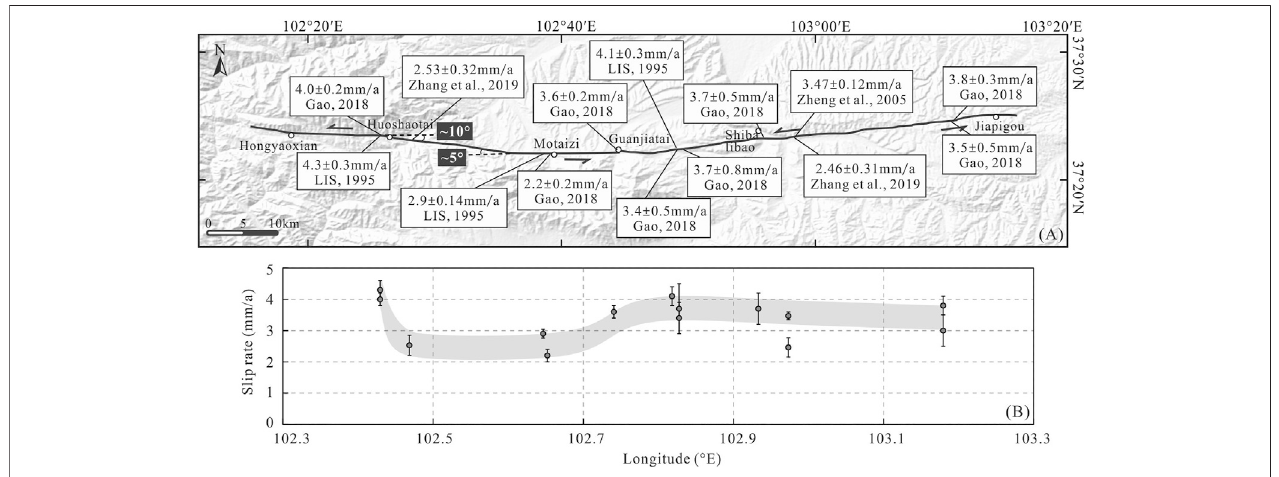
FIGURE 6 | (A) Distribution of left-lateral strike-slip rates along the Gulang fault. The slip rates are from (Lanzhou Institute of Seismology, 1995; Zheng et al., 2005; Gao,2018;Zhangetal.,2019).FaulttracesoftheGulangfaultbetweenHuoshaotaiandMotaizishowaminorchangeinfaultstrike. (B) Spatialvariationofslipratesalong the Gulang